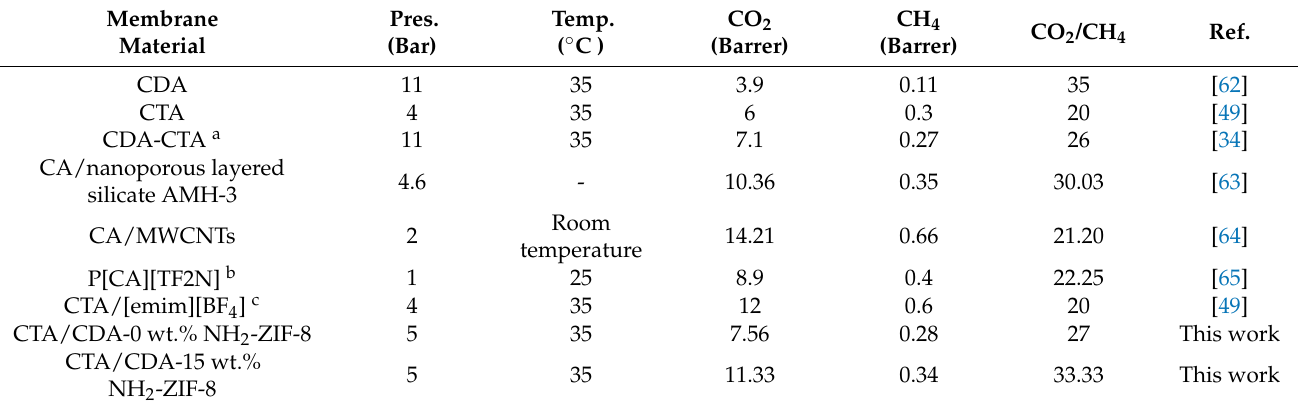
Table 4. Comparison of pure-gas separation performance of cellulose acetate (CA)-based membranes in the literature. Membrane Material